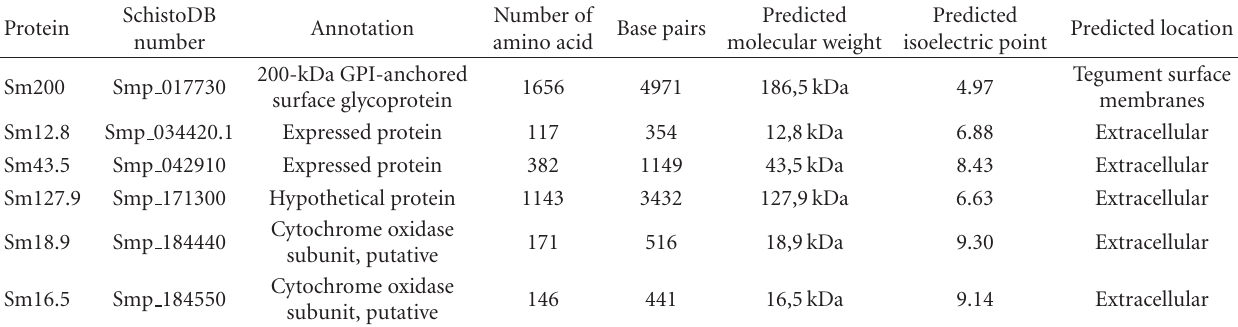
Table 2: Schistosoma mansoni protein selected by genome mining to be used in serological diagnosis for schistosomiasis. SchistoDB Number of Predicted Predicted Protein Annotation Base pairs Predicted location number amino acid molecular weight isoelectric point 200-kDa GPI-anchored Sm200 Smp 017730 1656 surface glycoprotein membranes Sm12.8 Smp 034420.1 Expressed protein Sm43.5 Sm127.9 Smp 171300 Hypothetical protein Sm18.9 Smp